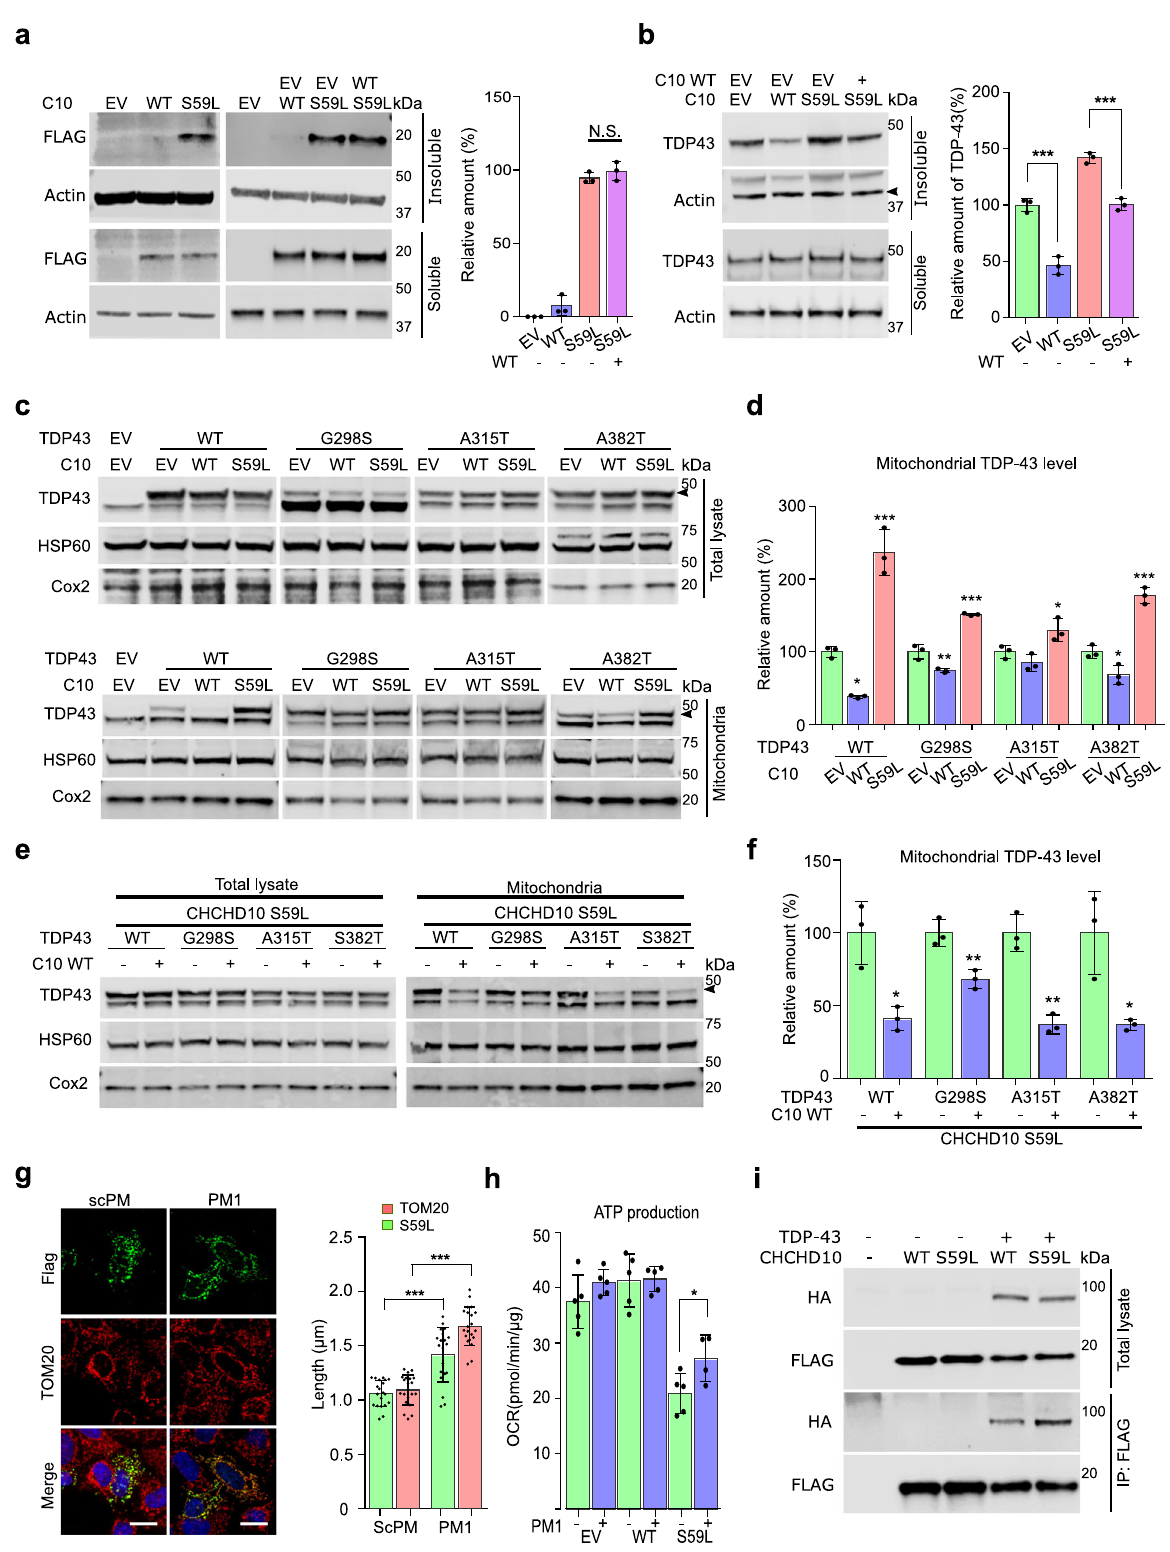
increased TDP-43 association with mitochondria in C2C10H S81L - expressing muscle tissues, as compared to C2C10H WT -expressing muscles (Supplementary Fig. 4e). These observations suggest that the prevention of TDP-43 mitochondrial translocation, as demonstrated by Wang et al. 25 , may be a potential therapeutic strategy for CHCHD10 -induced ALS-FTD. To test